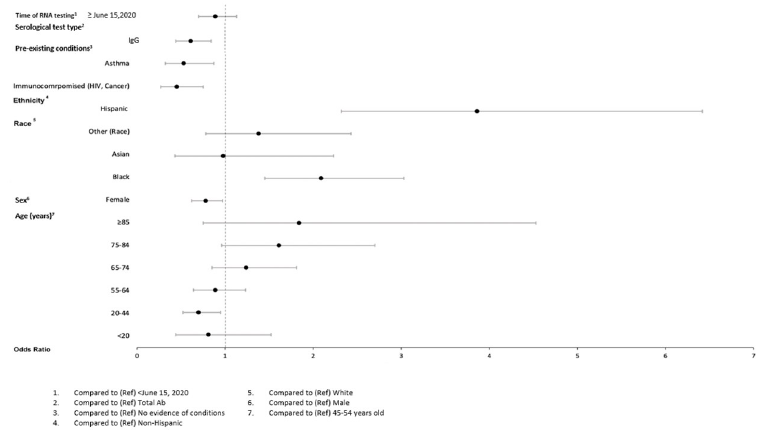
Fig 9. Odds of seropositivity dataset F.